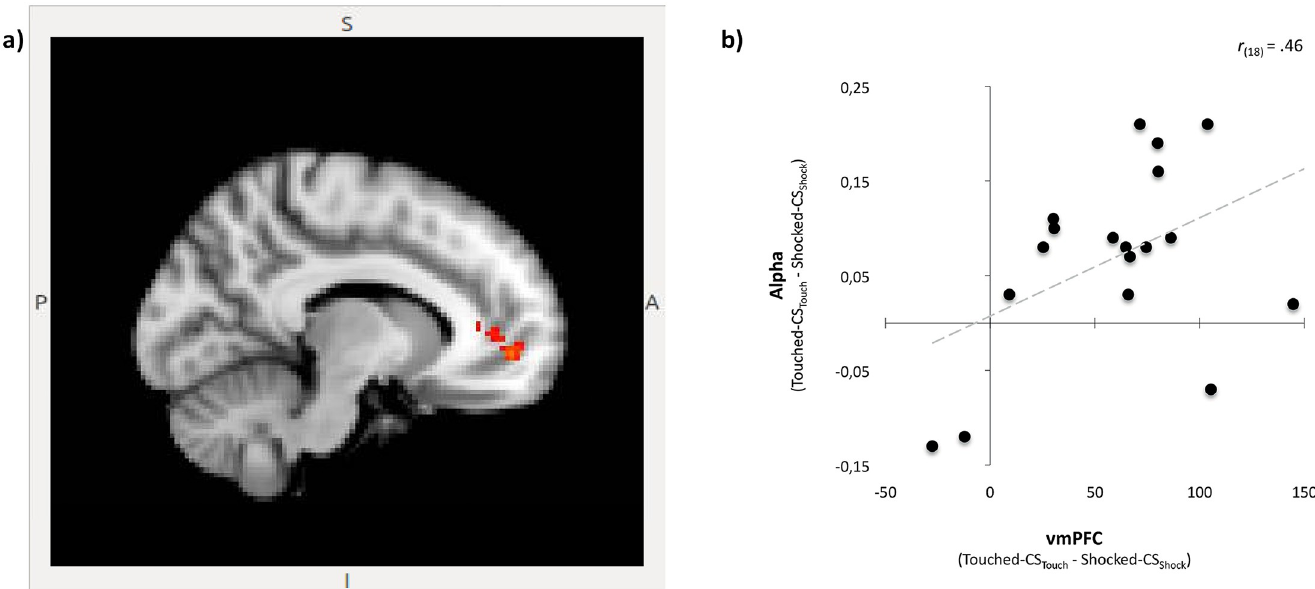
Fig 7. Linking the PT model valuation parameter α to brain activation. ( A ) vmPFC activation in Relief contrast. A Touched-CS Touch > Shocked-CS Shock contrast revealed activation within the vmPFC. We applied these masks to obtain a vmPFC ROI. ( B ) Correlation between vmPFC activity and α . Subsequent correlation analyses revealed that condition-specific activation in the vmPFC is positively related to condition-specific individual α -estimates. Note . CS = Conditioned Stimulus; vmPFC = ventro medial PreFrontal Cortex; PT = Prospect Theory.